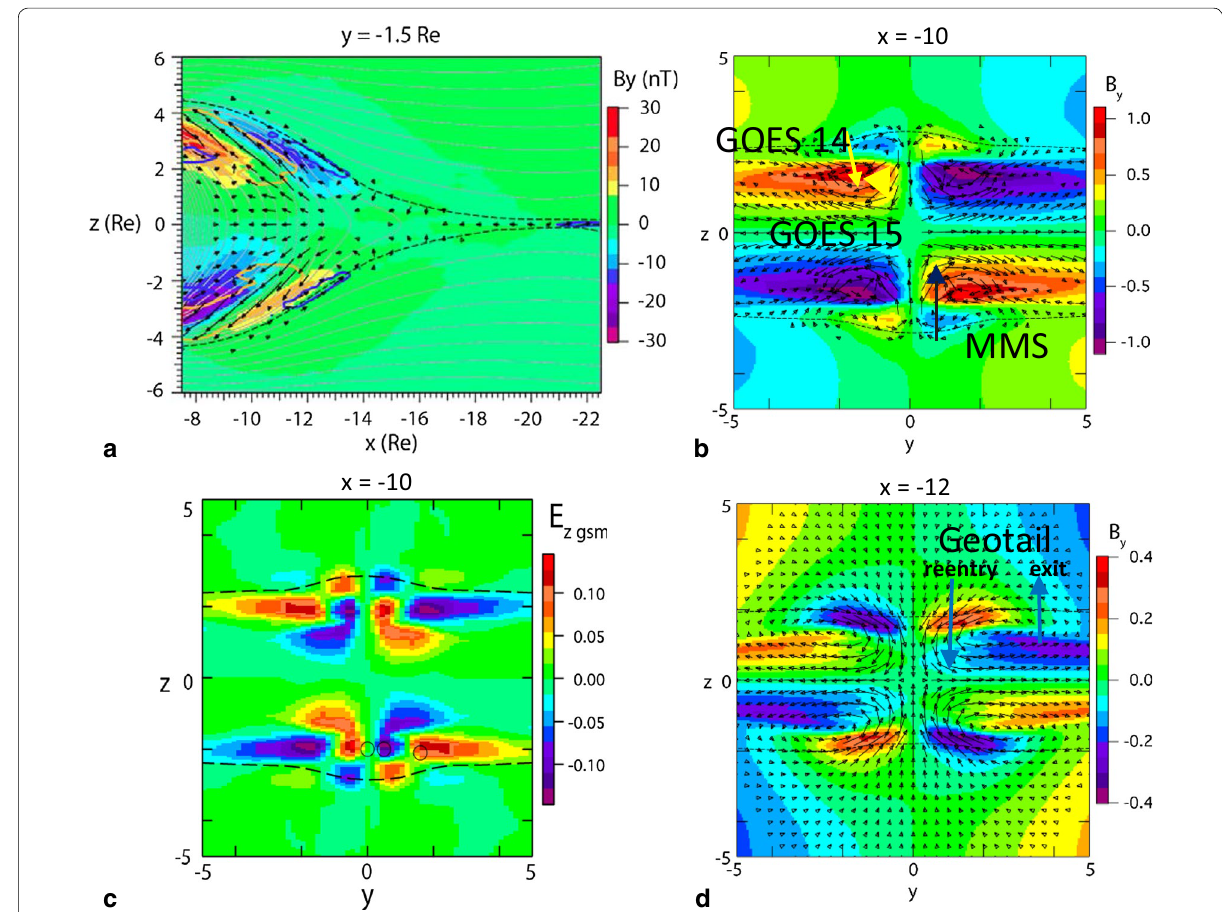
Fig. 5 Ez and By disturbances around the reconnection jets from MHD simulation by Birn and Hesse (2014). a Color‑coded By in the X – Z plane at t 132 and y 1.5 together with the current density vectors (Δ j ) from Birn and Hesse (2014). Heavy blue and orange contours indicate regions = = − of enhanced tailward and Earthward FACs, respectively. b Color‑coded By (normalized to 20 nT) in the Y – Z plane at t MMS and GOES 14–15 locations relative to the By pattern during the 10:01 UT dipolarization event (Figs. 3, 4) are indicated by arrows . c Color‑coded vertical (northward) electric field Ez (normalized to 20 mV/m) in the Y – Z plane at t at X 12. Possible Geotail location during the 10:14 UT dipolarization event is indicated by an arrow . Black arrows in b and d show the E = −